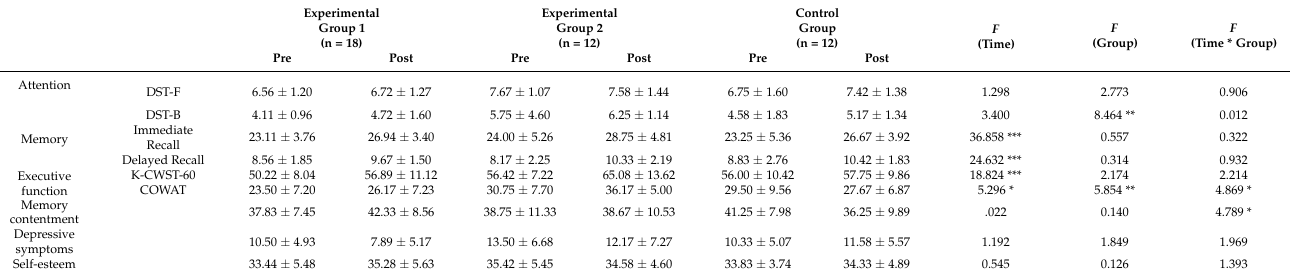
Experimental Experimental Group2 Group1 (n = 12) (n = 18)